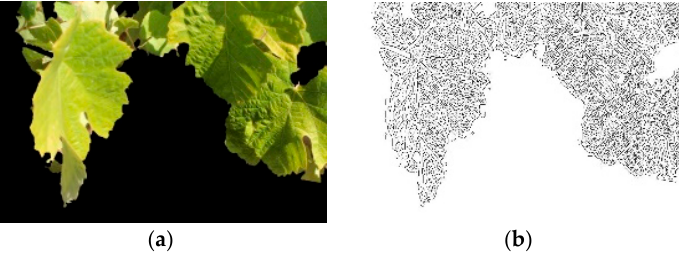
Figure 5. Canny edge detection operator: ( a ) Segmented leaf image; ( b ) Canny output result.